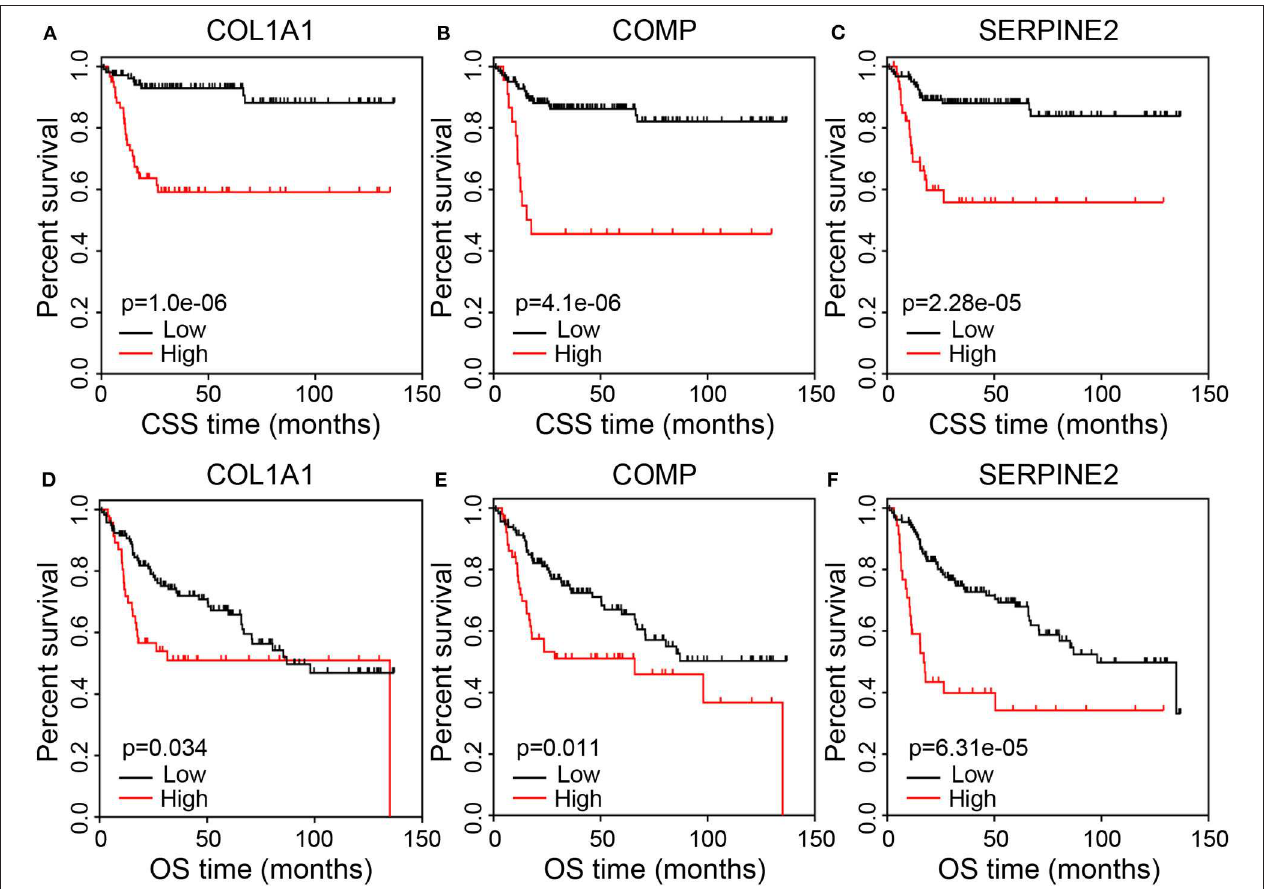
FIGURE 5 | Correlation of the prognostic genes with survival of BC patients. (A–C) Kaplan–Meier curves of CSS for patients grouped by expression levels of COL1A1, COMP, and SERPINE2. (D–F) Kaplan–Meier curves of OS for patients grouped by expression levels of COL1A1, COMP, and SERPINE2. BC, bladder cancer; CSS, cancer-specific survival; OS, overall